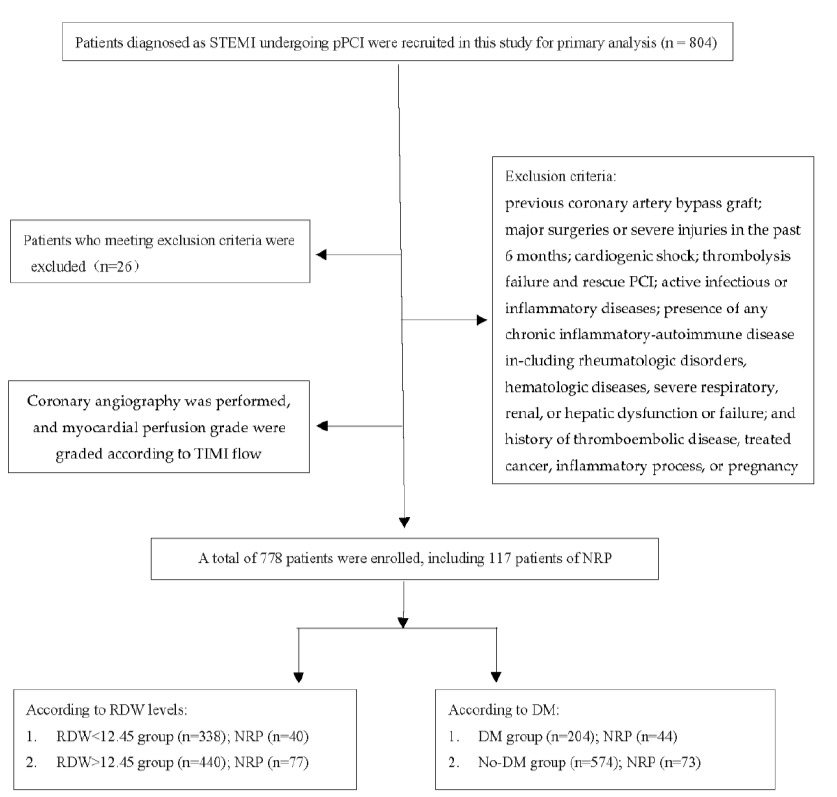
Figure 1. Flow chart illustrating the enrollment and the diagnosis procedure. Abbreviation: STEMI: ST-segment elevation myocardial infarction; pPCI: primary percutaneous coronary intervention; TIMI: thrombolysis in the myocardial infarction; NRP: no-reflow phenomenon; RDW: red blood-cell distribution width; DM: diabetes mellitus.